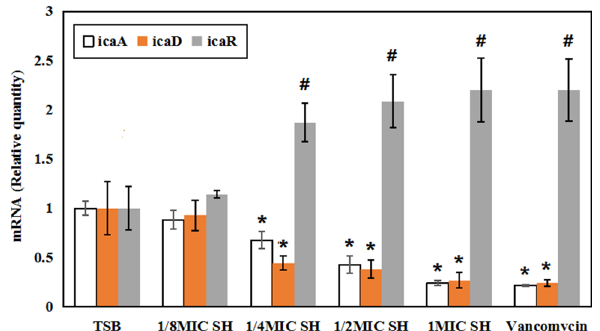
Figure 6. Analysis of ica gene expression (PCR). Compared with TSB and 1/8MIC SH groups, * P < 0.01, # P <